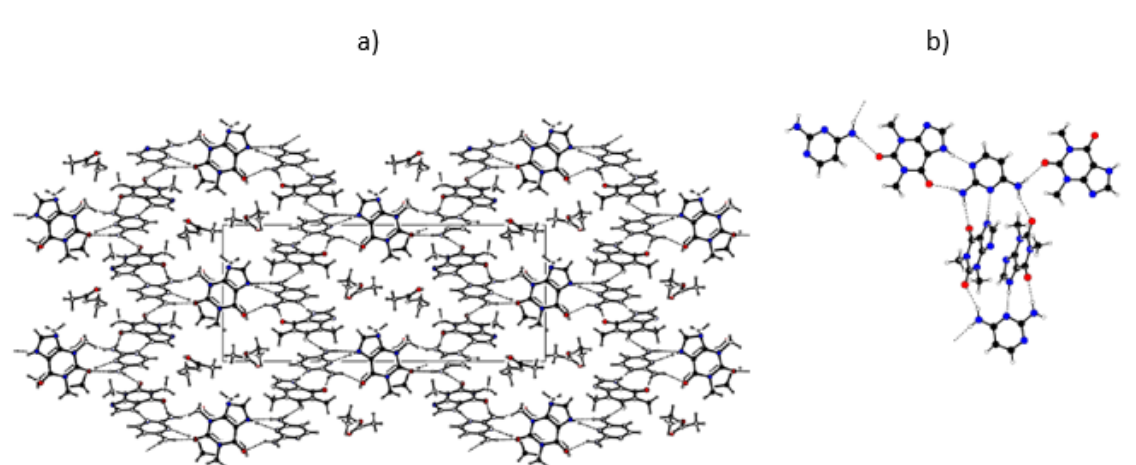
Figure 14. ( a ) Packing diagram for (1:2:1) DAP:THEO:EtAc viewed along the a axis. ( b ) Detail of the hydrogen bonded ribbons that join the 2,4-diaminopyrimidine and the theophylline molecules. Table 2. Hydrogen bonds in (1:2:1) DAP:THEO:EtAc solvate.